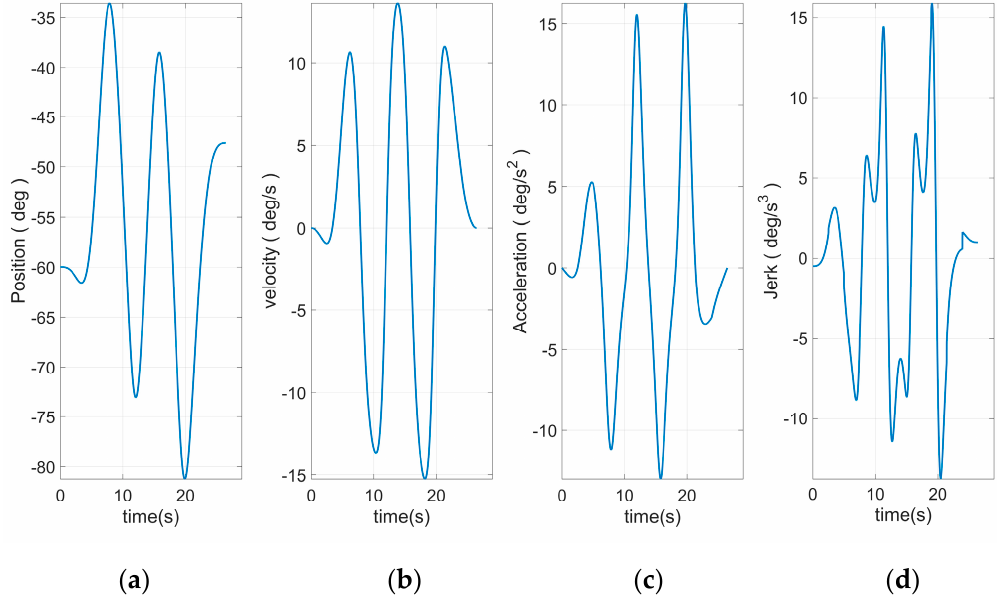
Figure 21. ( a ) Displacement of axis II over time by using seven segments S-curve. ( b ) Velocity of axis II over time by using seven segments S-curve. ( c ) Acceleration of axis II over time by using seven segments S-curve. ( d ) Jerk of axis II over time by using seven segments S-curve.